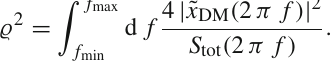
Fig. 4 Comparison of strain amplitudes of noise shown as black line and a DM hit in the BS in vertical (horizontal) direction shown as aqua (maroon) line. For more details, see main